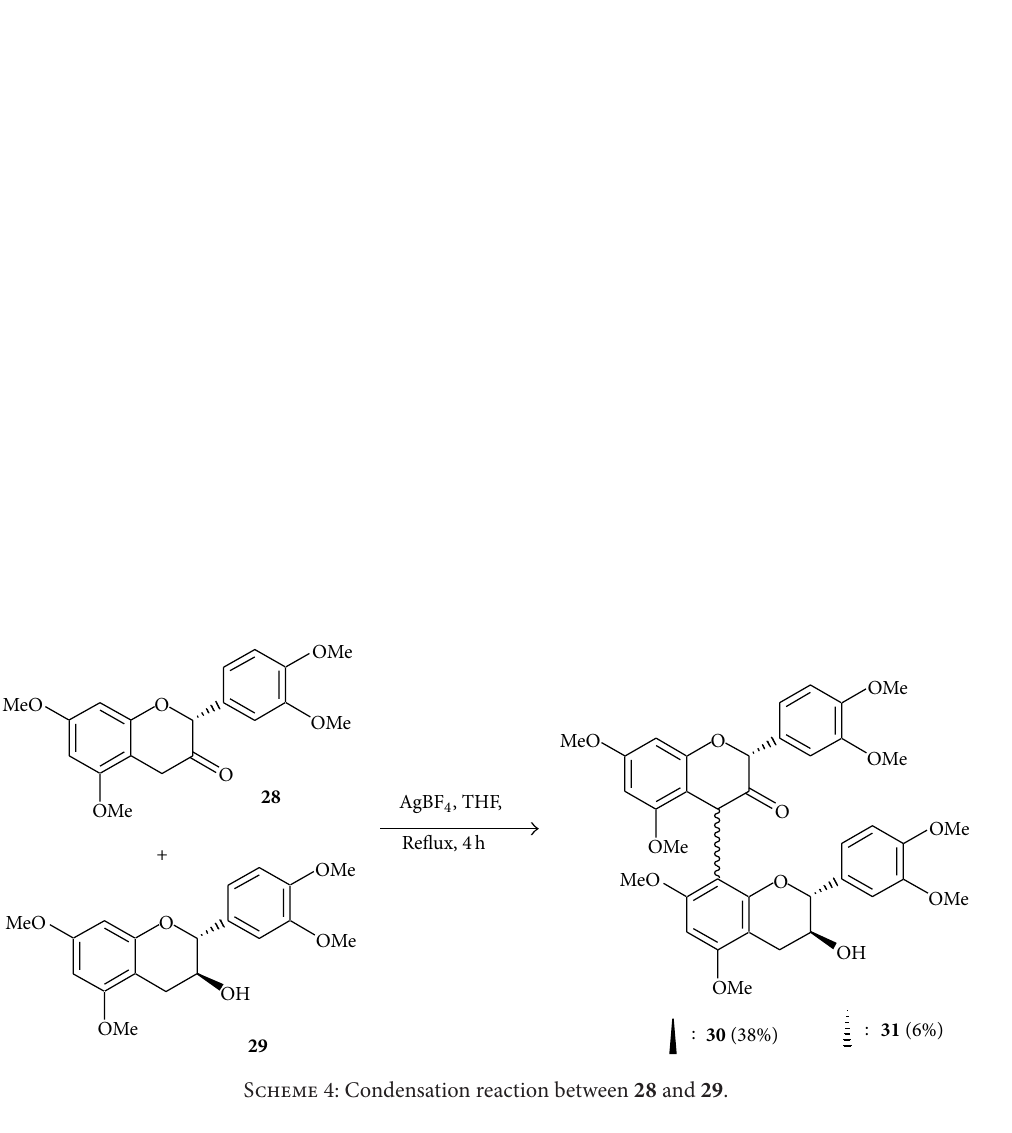
OMe OOMeO AgBF 4 , THF, :Reflux, 4 h (6%)+ OMeO